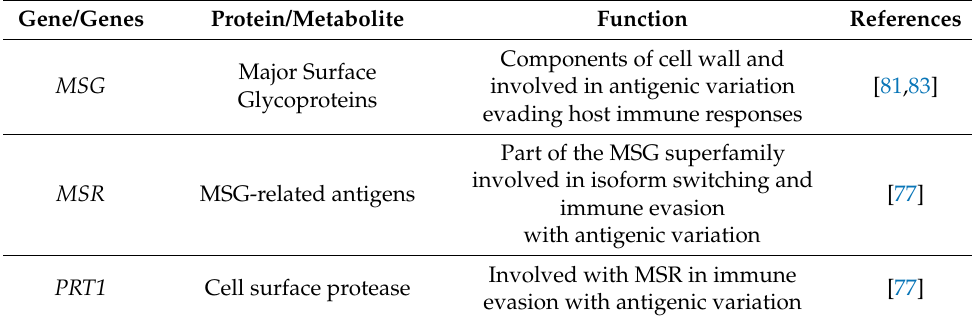
Table 5. Subtelomeric genes that increase pathogenicity in Pneumocystis